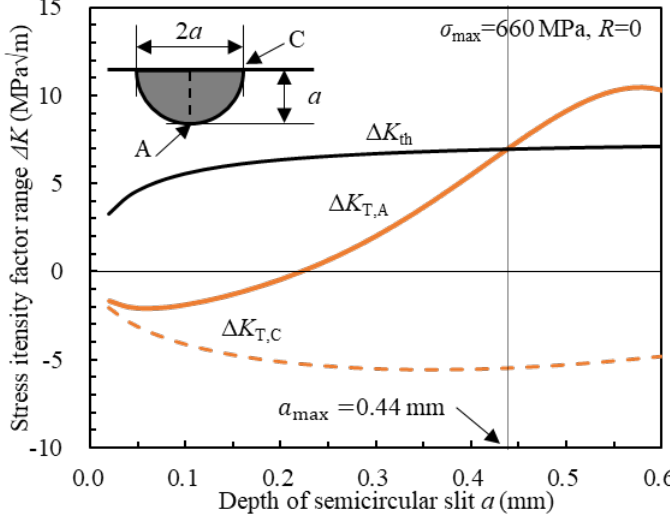
Figure 11. Estimation of the acceptable crack size.